Question: Sum up the contents of this chart in one sentence.
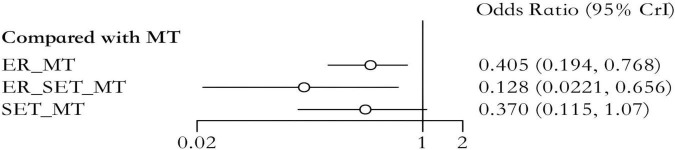
Answer: Forest plot of network meta-analysis for all-cause mortality, with MT as the common control. OR < 1 indicates lower mortality risk in the intervention group. ER + MT, endovascular revascularization plus medication; ER + SET + MT, endovascular revascularization plus supervised exercise plus medication; SET + MT, supervised exercise plus medication; MT, medication.